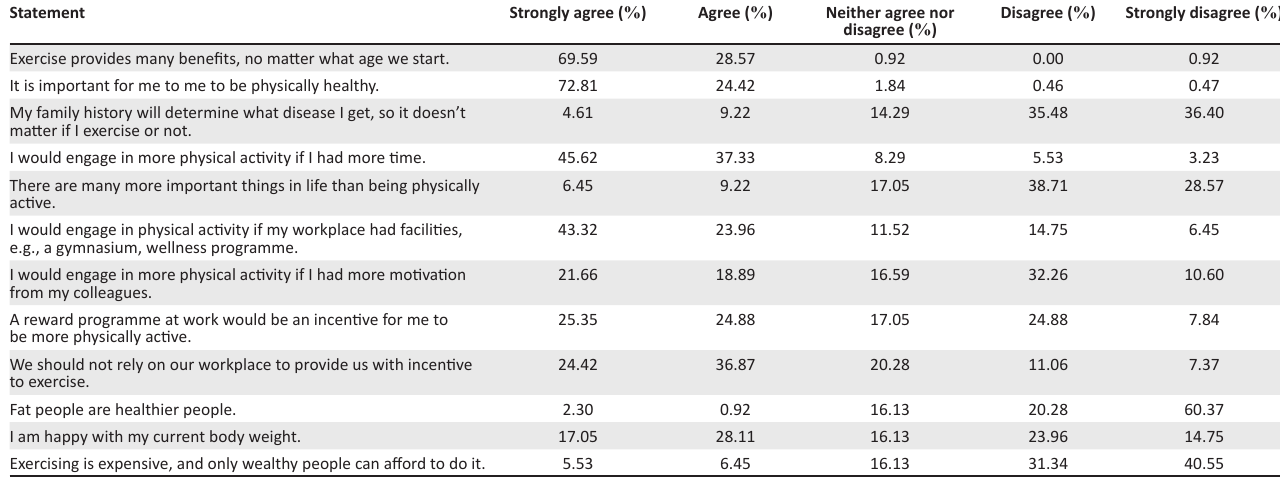
TABLE 4: Participants’ attitudes towards physical activity. Statement